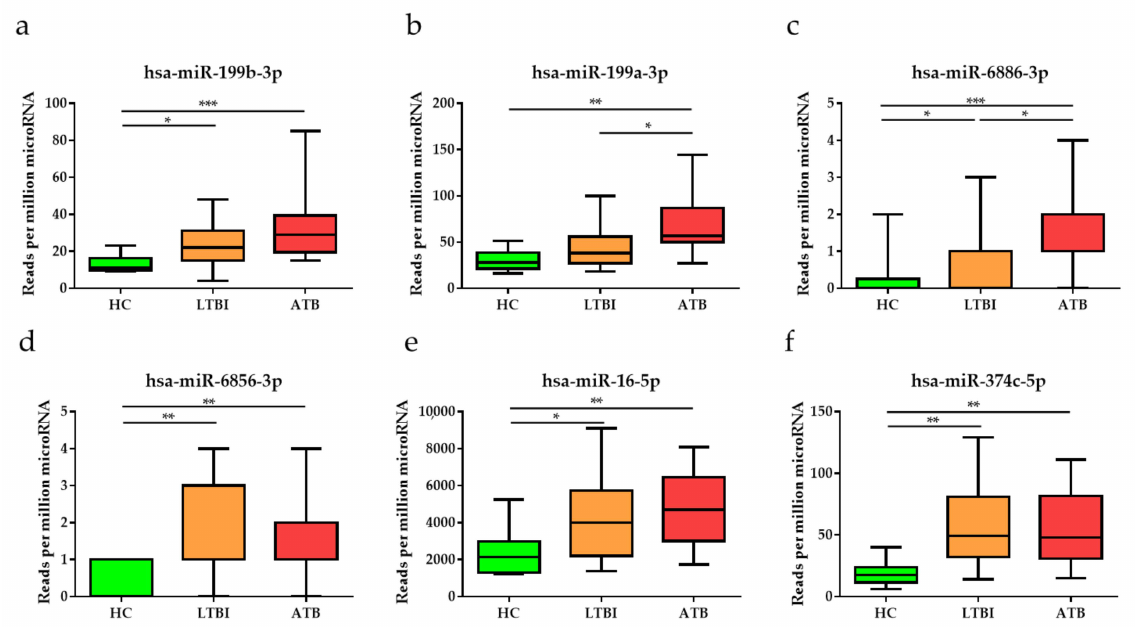
Figure 2. Expression levels of the top six differentially expressed miRNAs, namely ( a ) miR-199b-3p, ( b ) miR-199a-3p, ( c ) miR-6886-3p, ( d ) miR-6856-3p, ( e ) miR-16-5p, and ( f ) miR-374c-5p, in patients with active tuberculosis (ATB), individuals with latent tuberculosis infection (LTBI), and healthy controls (HCs). Data are reported as mean ± standard deviation. * p < 0.05, ** p < 0.01, *** p <